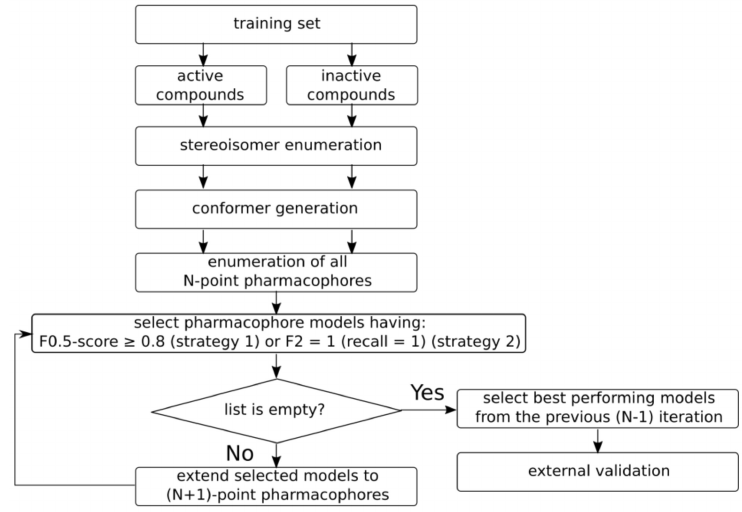
Figure 6. Overall workflow of pharmacophore model